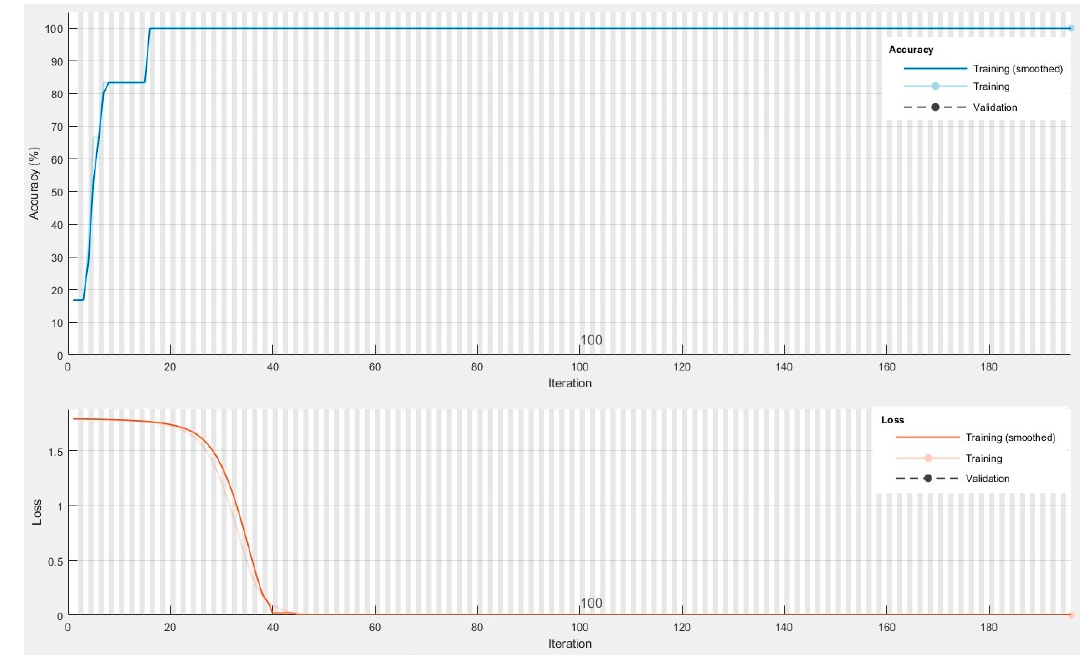
Figure 14. Training and testing curve by CNNs.